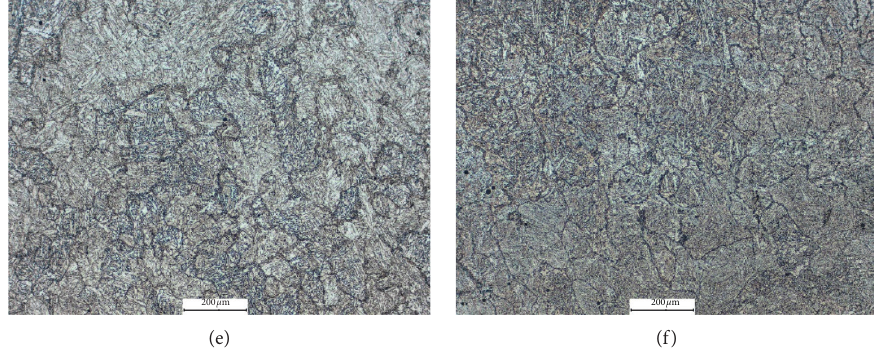
Figure 3: Microstructures of the specimens: (a) columnar crystals in sample #1, (b) columnar crystals in sample #2, (c) remelted zone in sample #1, (d) remelted zone in sample #2, (e) heat-affected zone in sample #1, and (f) heat-affected zone in sample